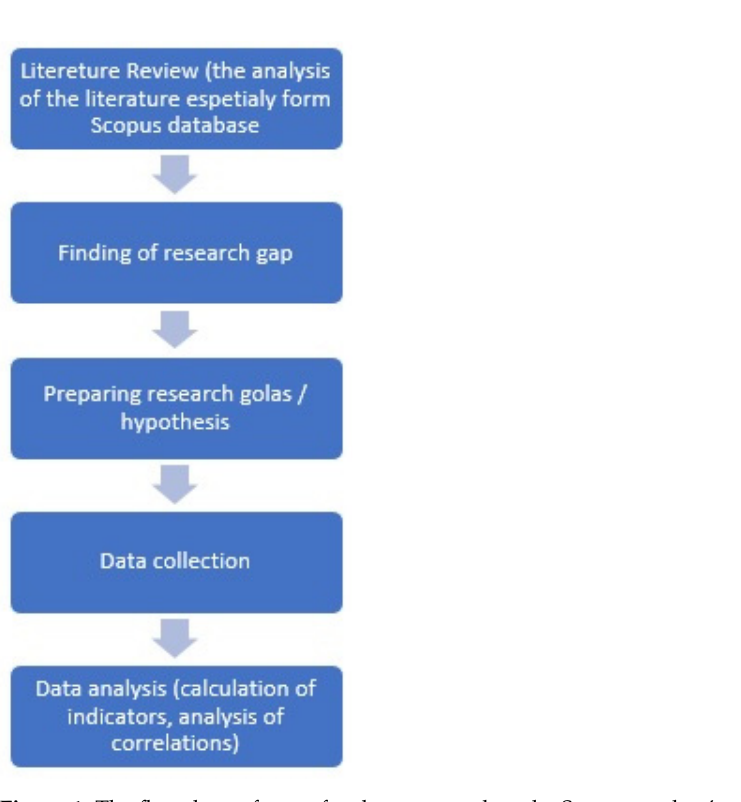
Figure 1. The fl owchart of steps for the presented study. Source: author’s own analysis. Figure 1. The flowchart of steps for the presented study. Source: author’s own analysis.